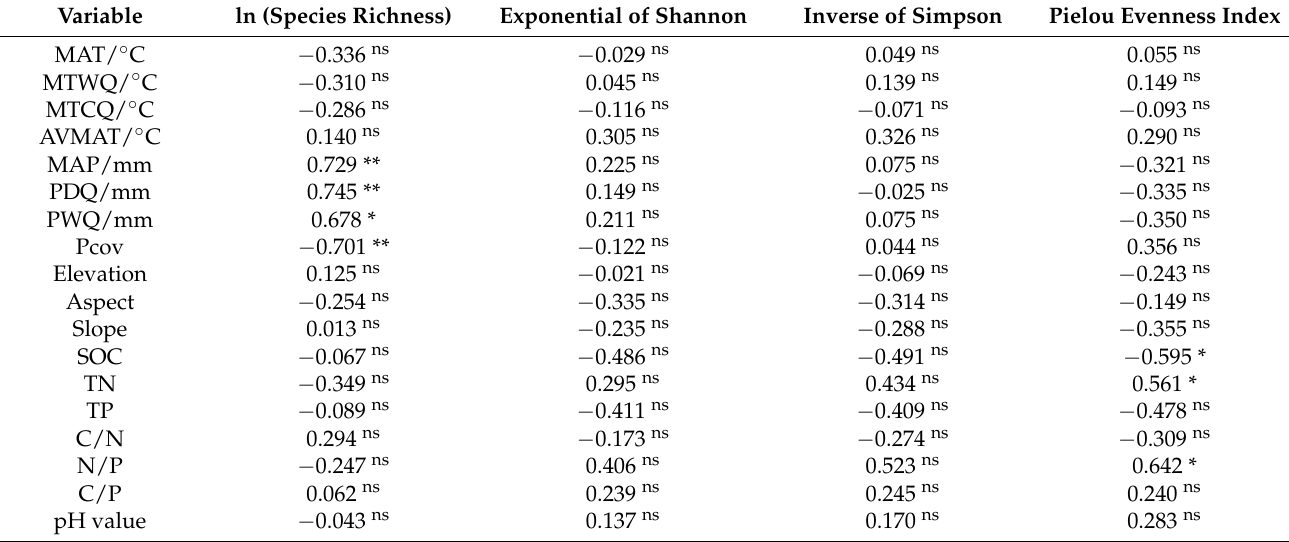
Table 2. The correlation between species diversity indices and environmental factors.